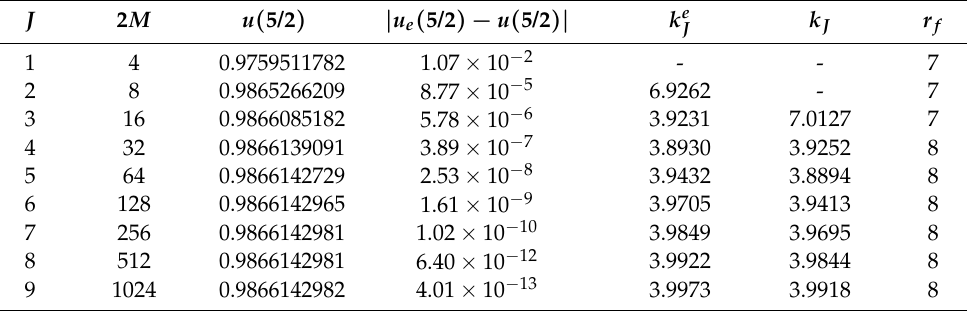
Table 2. Solutions to (17) where u e ( 5/2 ) = 0.986614298151 using HOHWM.